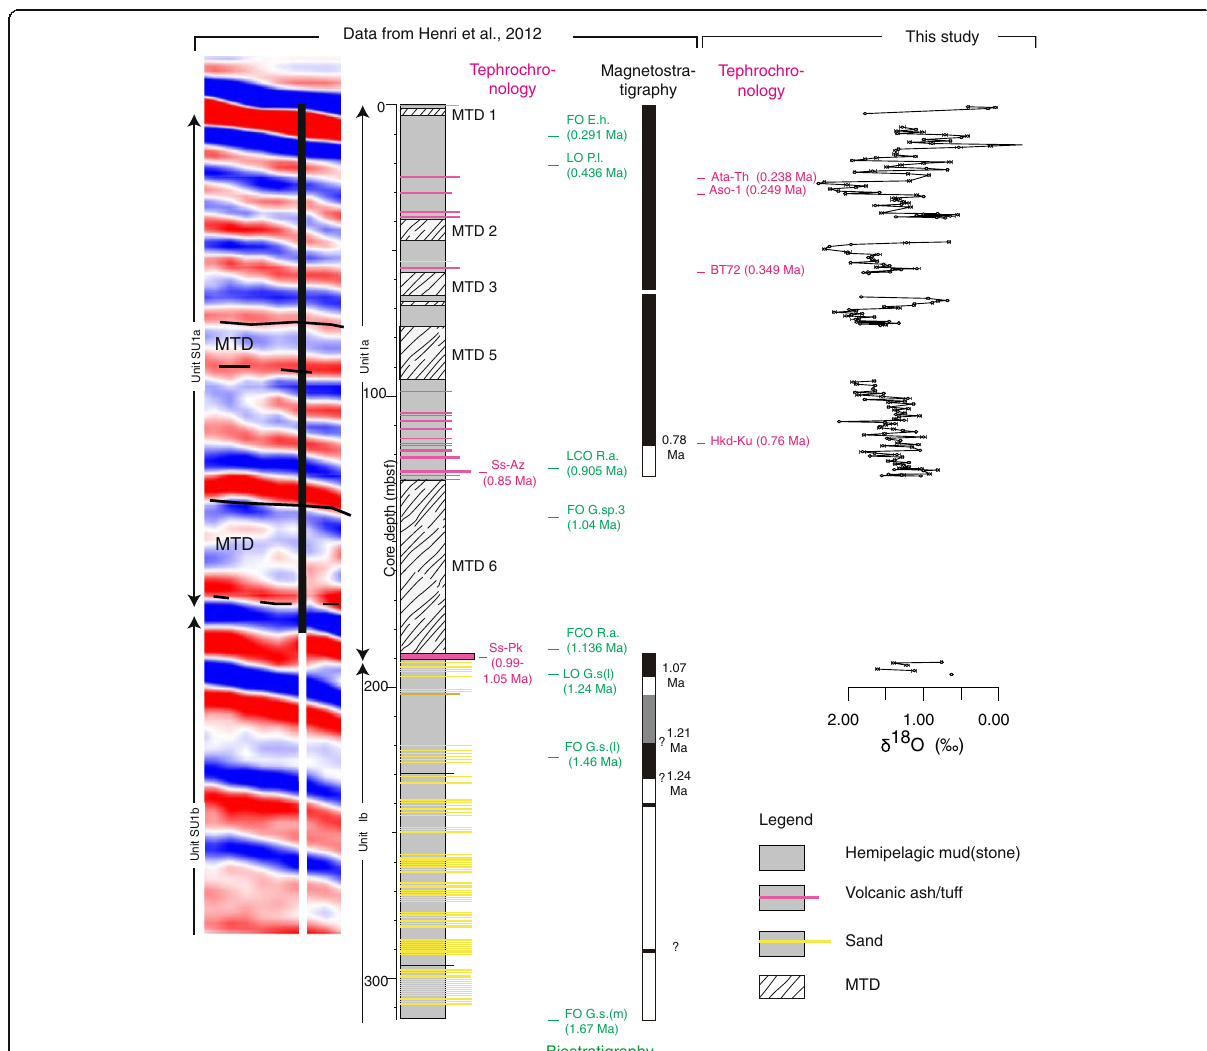
Fig. 3 Correlation of seismic data with core C0018. Data from previous studies are shown, including lithology and dating of C0018 based on magnetostratigraphy, nannofossil biostratigraphy, and tephrochronology (Ss-Az and As-Pnk) from lithological unit U1a (Henry et al. 2012). Data from this study include δ 18 O data and tephrochronology (Ata-Th, Aso-1, BT72, and